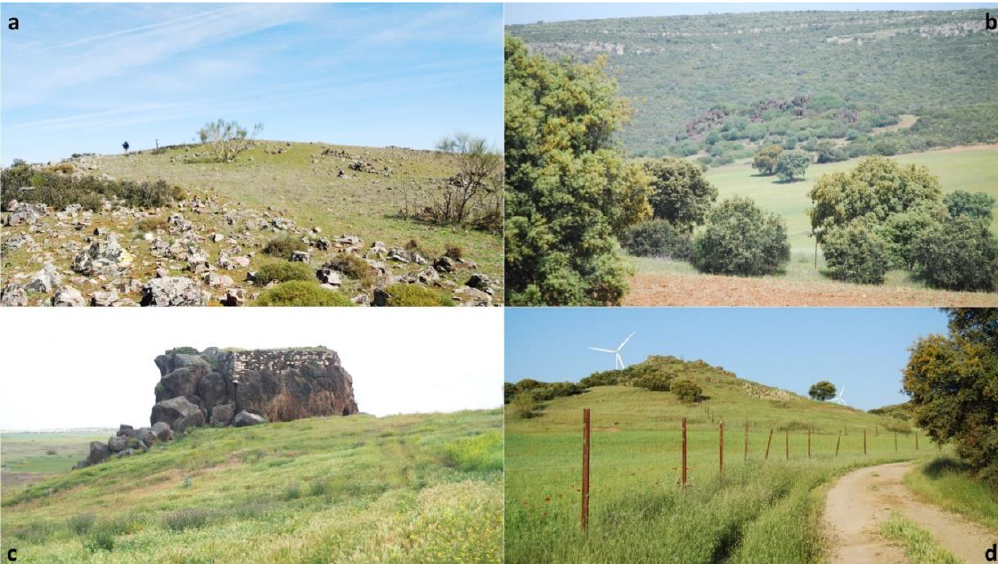
Figure 4. Some examples of spatter cones: ( a ) La Sima (Granátula de Calatrava); ( b ) Peñas Negras (Piedrabuena); ( c ) Peñón de Ciruela (Ciudad Real); ( d ) Pozo Blanco (Moral de Calatrava).